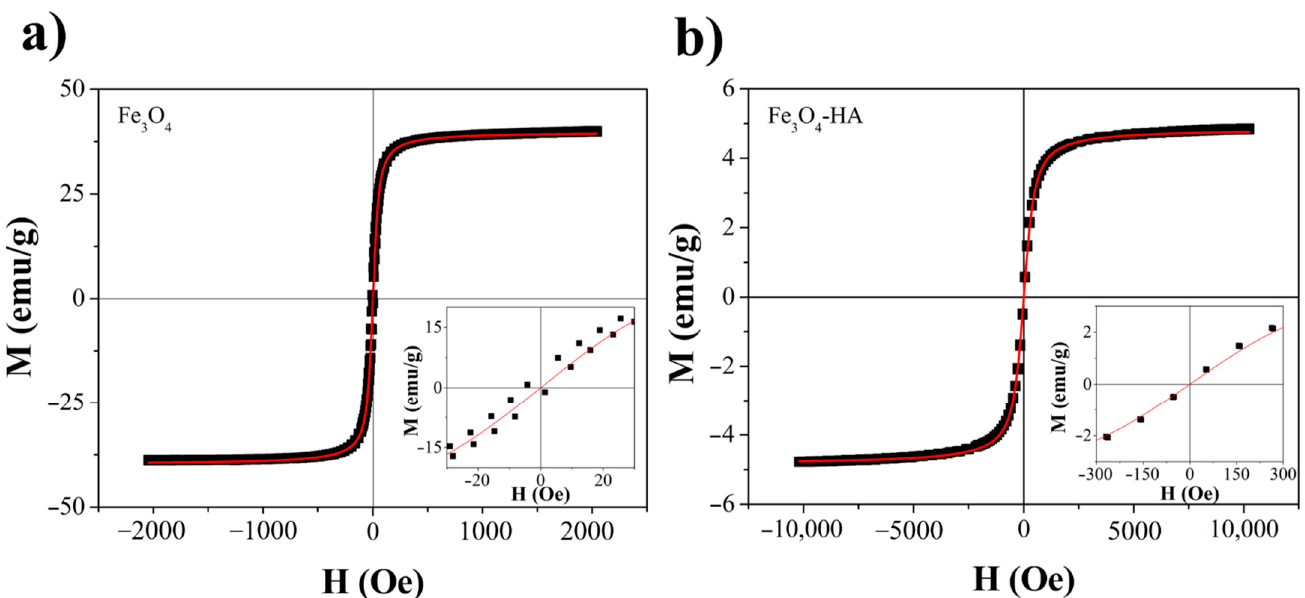
Figure 3. Magnetization measurements of ( a ) the Fe 3 O 4 and ( b ) Fe 3 O 4 -HA samples. The red line denotes the description of the experimental data using the Langevin function.